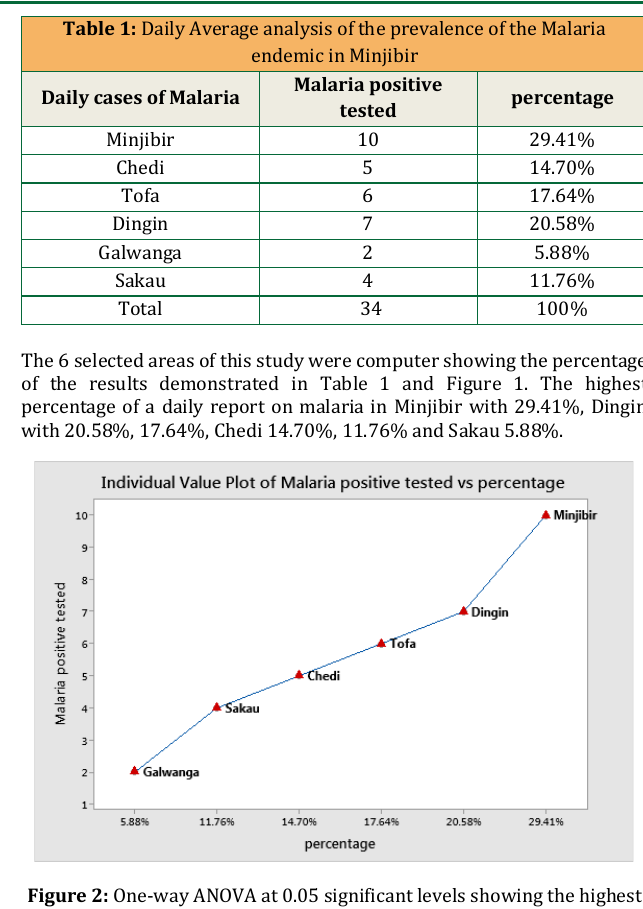
Figure 2: One-way ANOVA at 0.05 significant levels showing the highest